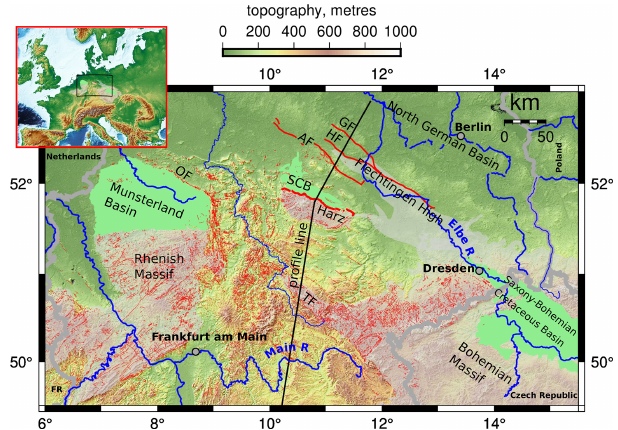
Figure 1. Overview of Late Cretaceous basins in central western Europe and associated basement structures and massifs. The line of cross section from Fig. 3a is shown. The inset shows the figure location (black square). Abbreviations: OF – Osning Fault; GF – Gardelegen Fault; HF Haldensleben Fault; AF – Allertal Fault; TF – Thuringian Forest. Topography is from EU-DEM v1.0 (Mouratidis and Ampatzidis, 2019). Faults are from GÜK200 (Zitzmann, 2003), and Malz et al. (2020).